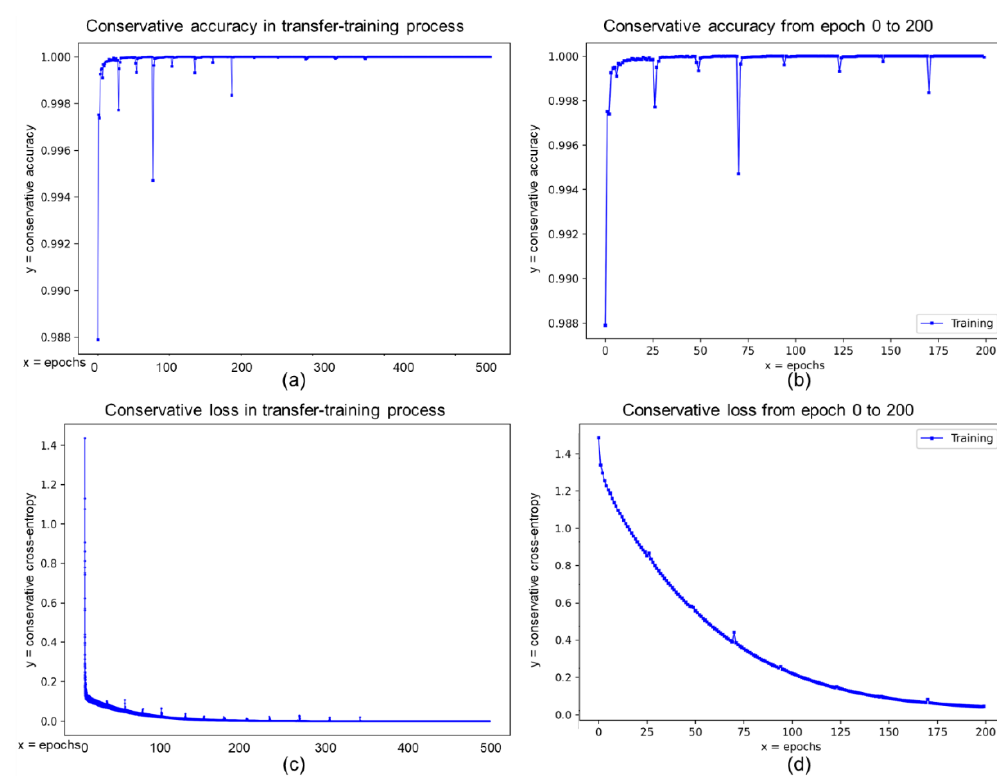
Figure 13. The conservative loss ( 𝑙𝑜𝑠𝑠 𝑐𝑜𝑛 ) and conservative accuracy ( 𝑎𝑐𝑐 𝑐𝑜𝑛 )) records of the transfer-training process in training and validation set (augmentation data). ( a , b ) refer to the epoch-wised 𝑎𝑐𝑐 𝑐𝑜𝑛 in the transfer-training process. ( c , d ) correspond to the epoch-wised 𝑙𝑜𝑠𝑠 𝑐𝑜𝑛 in the transfer-training process. ( b , d ) are the enlarge figures between epoch 0 and 200 from ( a , c ).